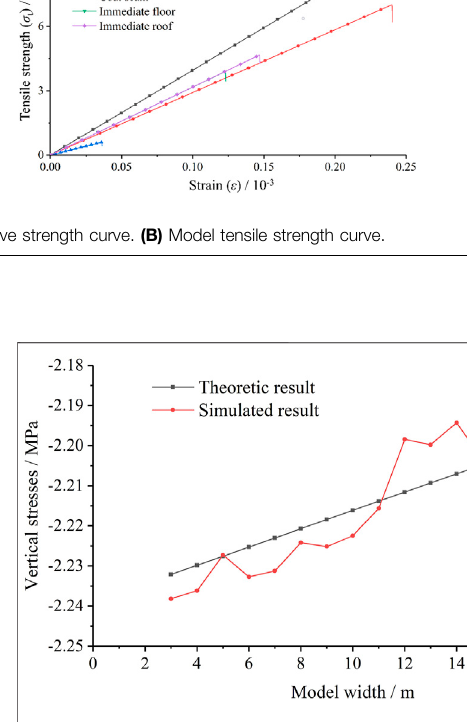
FIGURE 7 | Comparison of theoretical calculation and numerical simulation results of vertical stress.